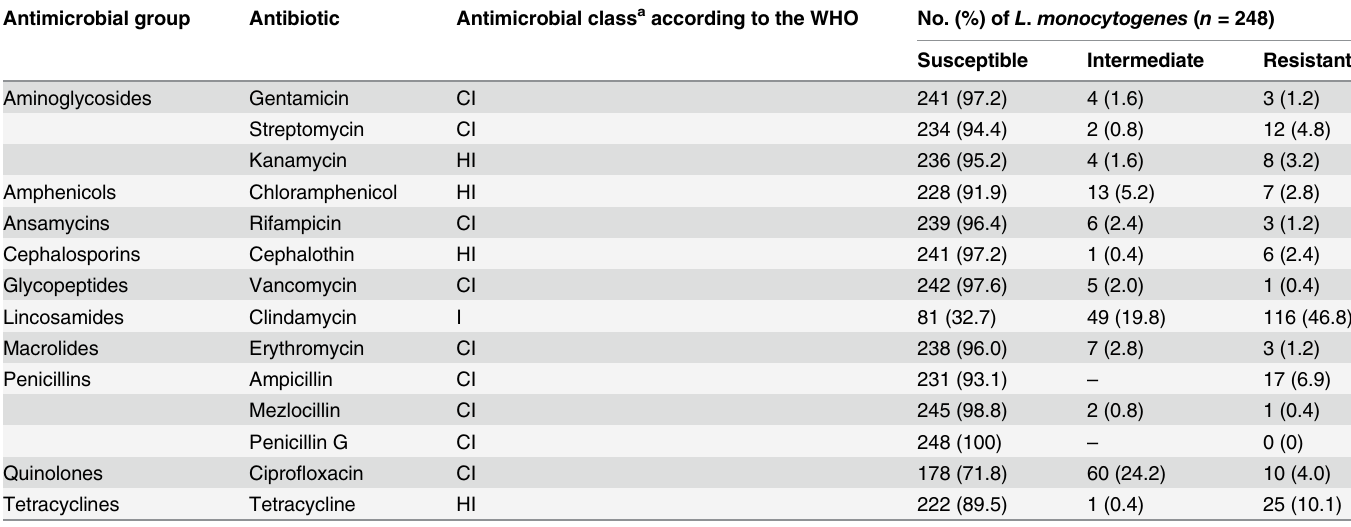
Table 6. Results of antimicrobial susceptibility tests of Listeria monocytogenes isolates obtained from retail raw food in China. Antimicrobial group Antimicrobial class a according to the